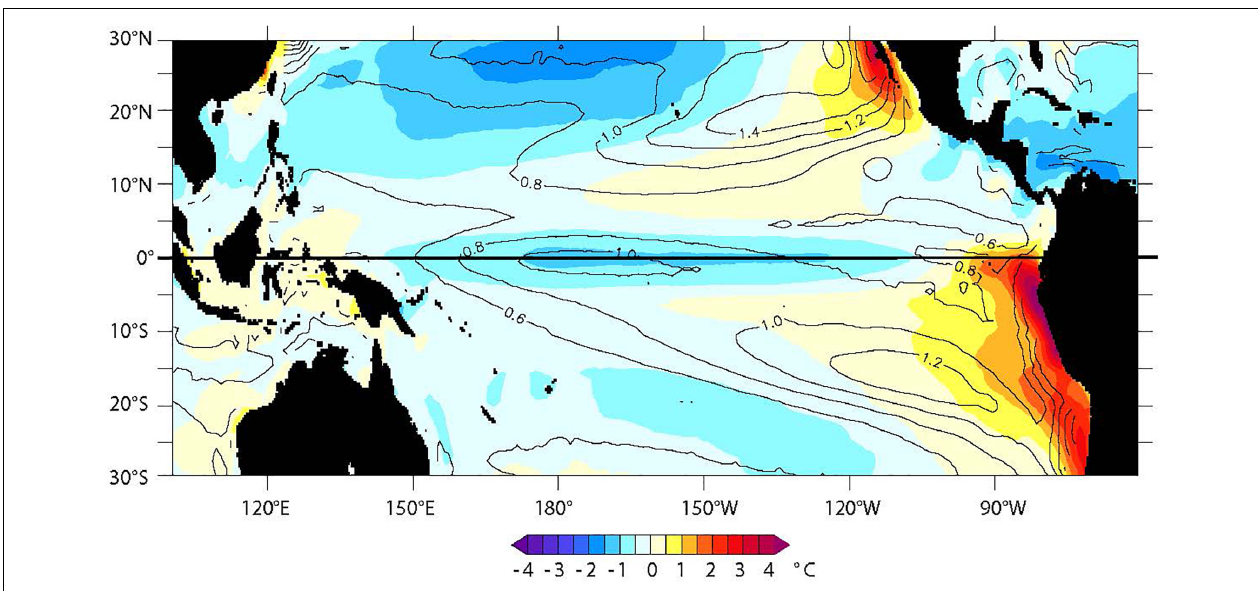
FIGURE 7 | Mean SST bias (colors) of an ensemble of 39 coupled GCMs from the CMIP5 historical experiments over 1982–2005 relative to Reynolds SST (Reynolds et al., 2007). The contours indicate the standard deviation of the mean bias amongst the model ensemble (in ◦